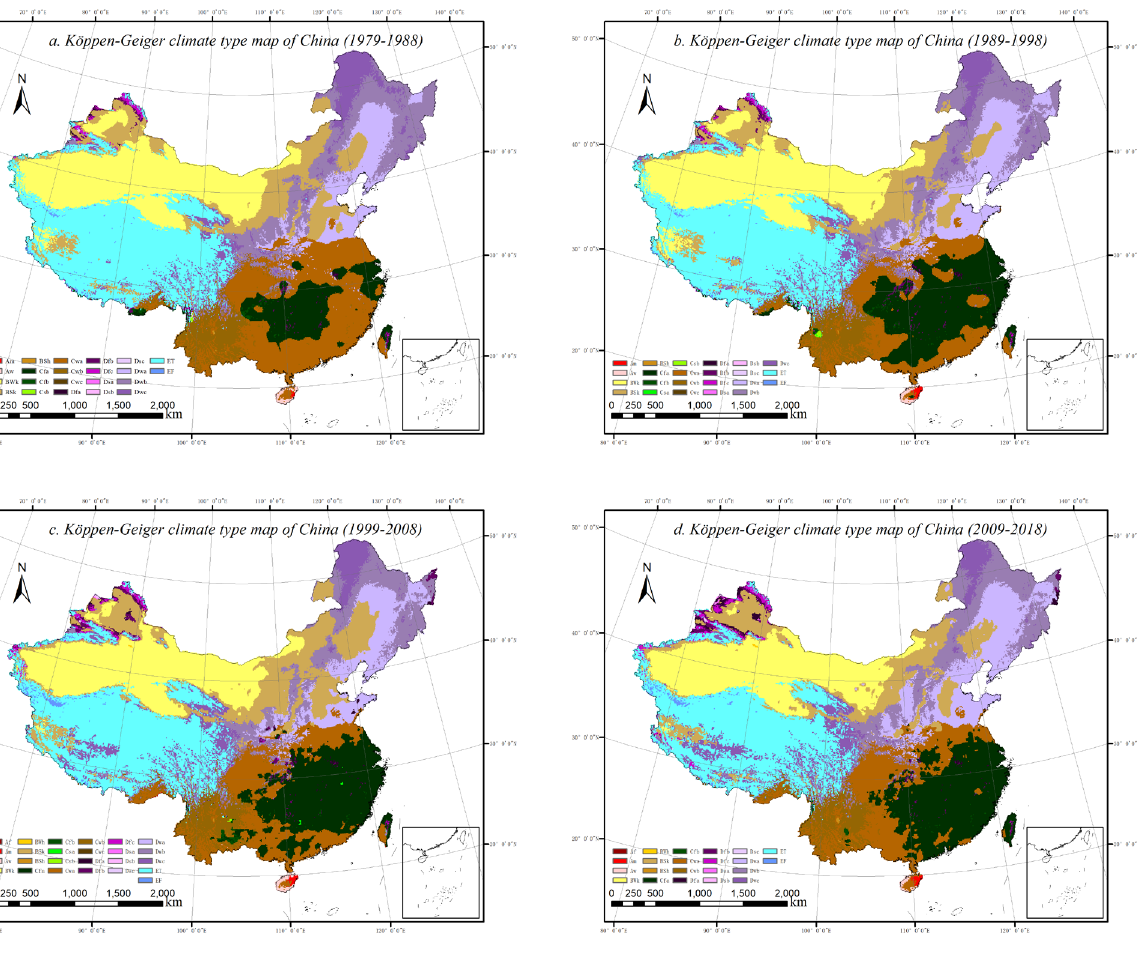
Figure 1. Decadal change of Köppen-Geiger climate type map of China in past 40 years